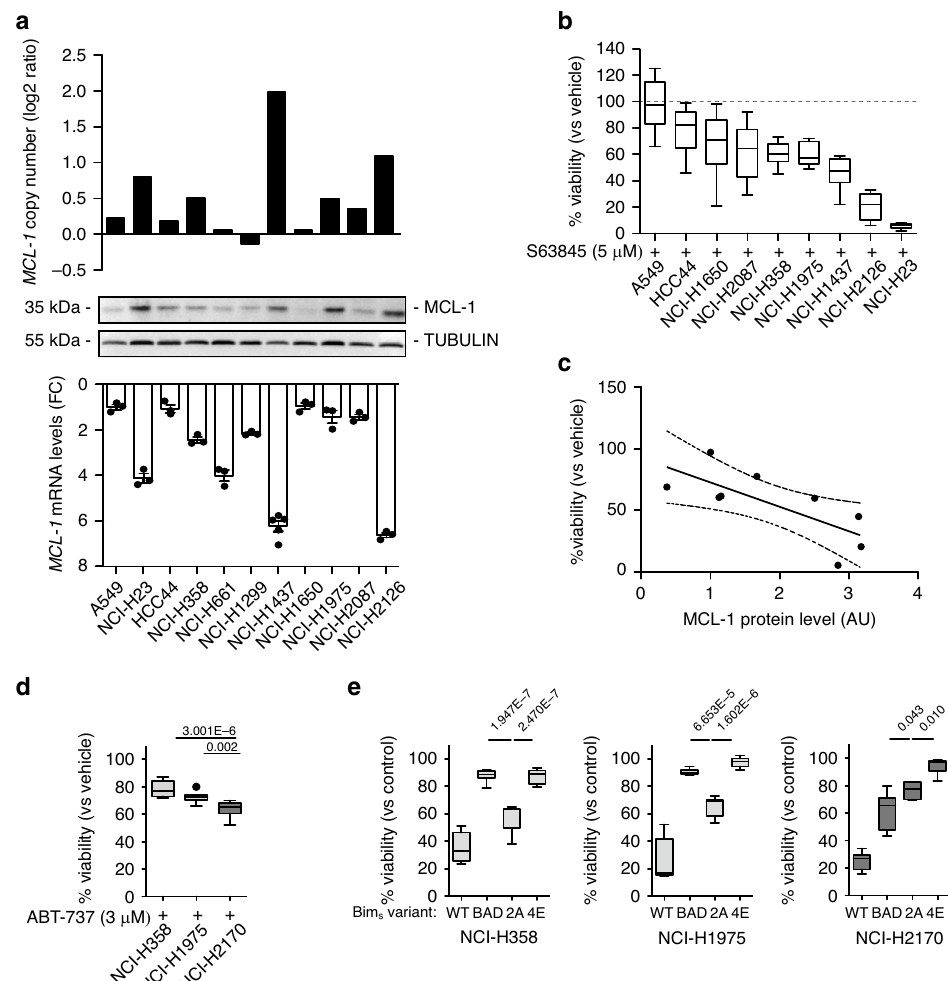
Fig. 4 MCL-1 secures survival of lung cancer derived cell lines. a MCL-1 copy number variation, MCL-1 mRNA, and MCL-1 protein levels in the cell lines used for this study. Data in the bottom panel are presented as mean ± SEM. b Relative viability of the indicated cell lines after 72 h treatment with 5 µ M S63945, as determined by CellTiter-Glo ® . Results were normalised to vehicle treated (control) cells. c Simple linear regression between MCL-1 protein levels (AU, arbitrary units) and cell viability after S63945 treatment (dashed lines 95% con fi dence interval; R 2 = 0.5441, p = 0.0233). d Relative viability of the cell lines after 72 h treatment with 3 µ M ABT-737, as determined by CellTiter-Glo ® . Results were normalised to vehicle treated (control) cells (one-way ANOVA p = 4.540E − 6, F (2,26) = 20.49). e Relative viability of the indicated cell lines 24 h after induction of the expression of the different BIM S variants, as determined by FACS analysis. Percentage of viable untreated cells was assigned as 100% (one-way ANOVA: NCI-H358: p = 2.317E-12, F (3,24) = 75.45; NCI-H1975: p = 1.354E − 13, F (3,24) = 97.82; NCI-H2170: p = 3.334E – 12, F (3,20) = 70.48). In fi gure are reported the p value from the post-hoc analysis with Bonferroni correction. Data in panel ( b , d , and e ) are presented as box plots, where the centre line represents the median value, the limits represent the 25th and 75th percentile, and the whiskers represent the minimum and maximum value of the distribution, excluding outliers de fi ned using the IQR rule. Each cell line was assayed at least in three independent